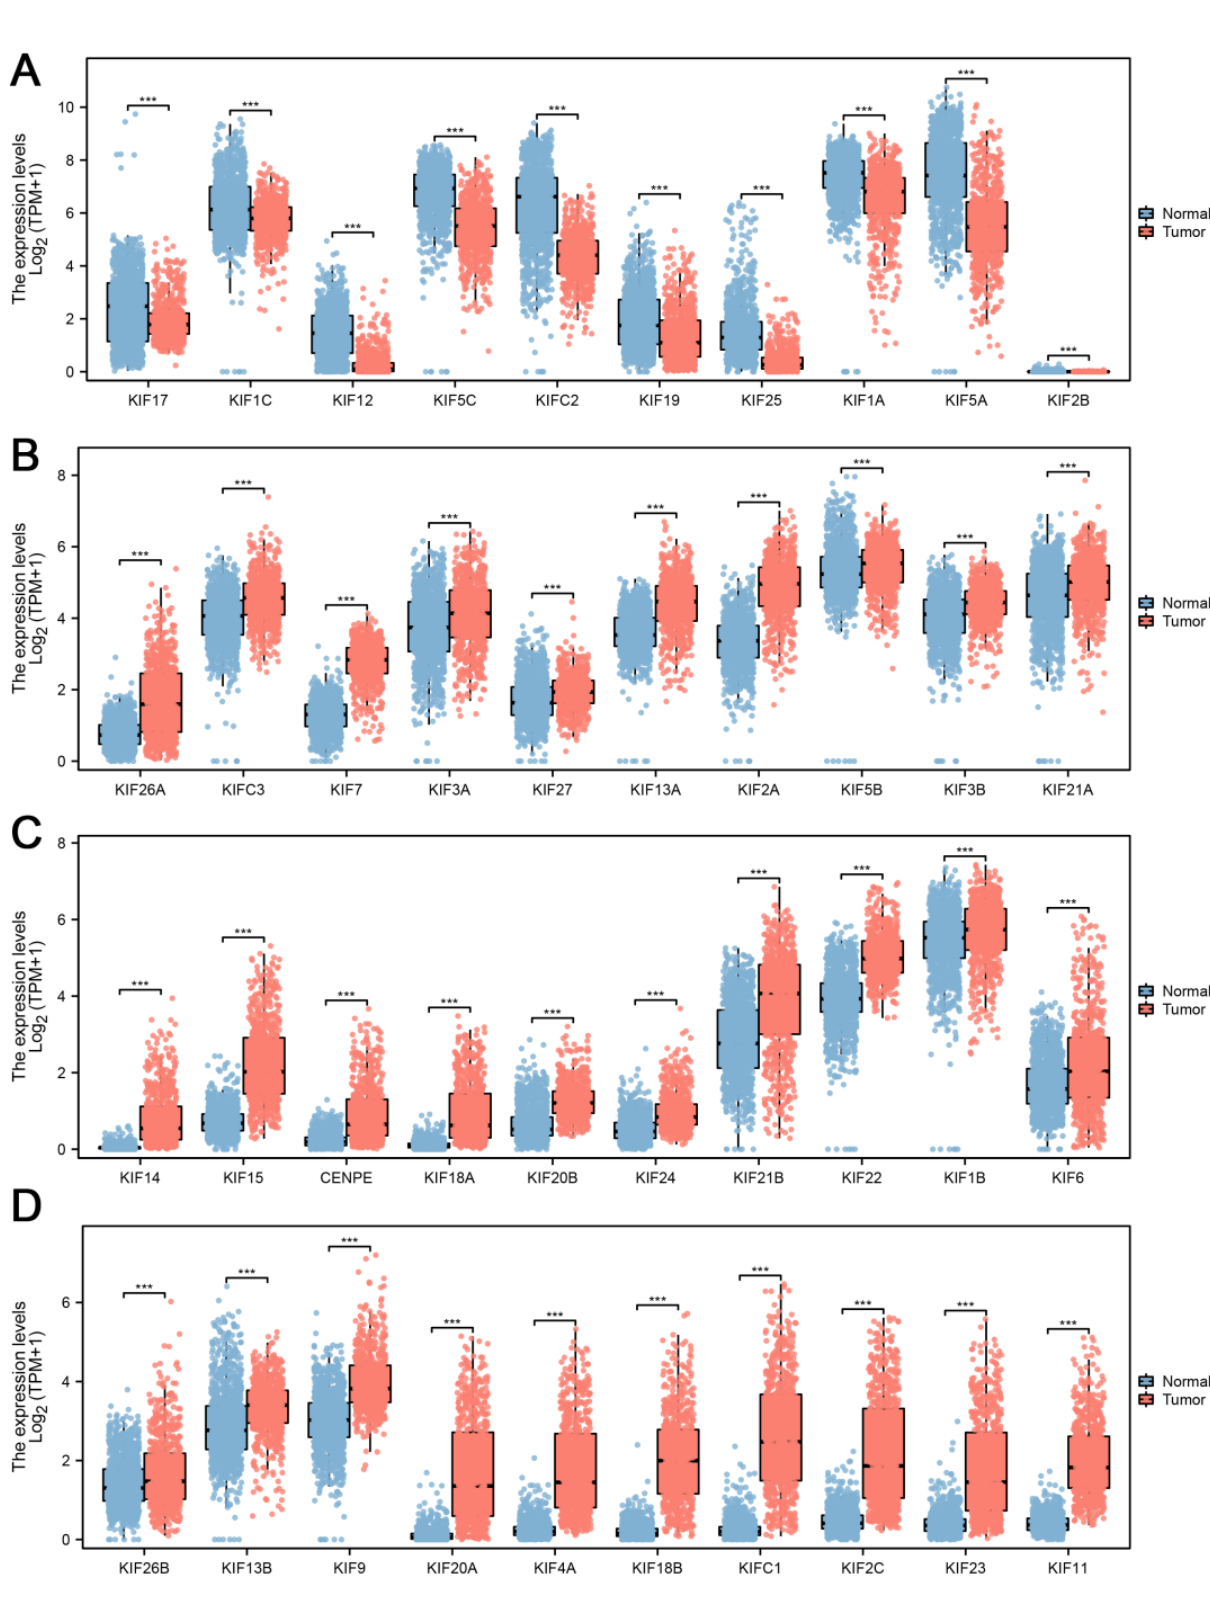
Figure 2. Differential expression analysis of KIFs. Notes: ( A ) 10 KIFs, including KIF17, KIF1C, KIF12, KIF5C, KIFC2, KIF19, KIF25, KIF1A, KIF5A, and KIF2B, were found to decrease expression in tumor samples using both TCGA and matched GTEx data; ( B – D ) another 30 KIFs were found upregulated in tumor samples. (* p < 0.05, ** p < 0.01, *** p < 0.001)